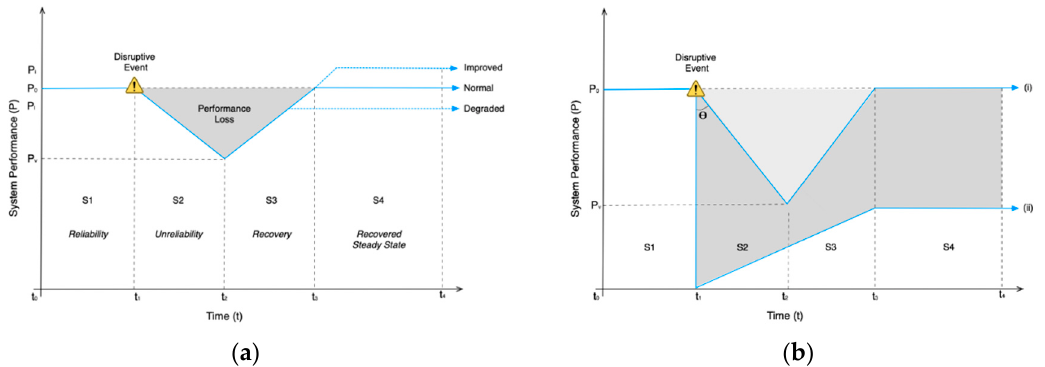
Figure 2. ( a ) Generic resilience curve; ( b ) different impacts on resilience.